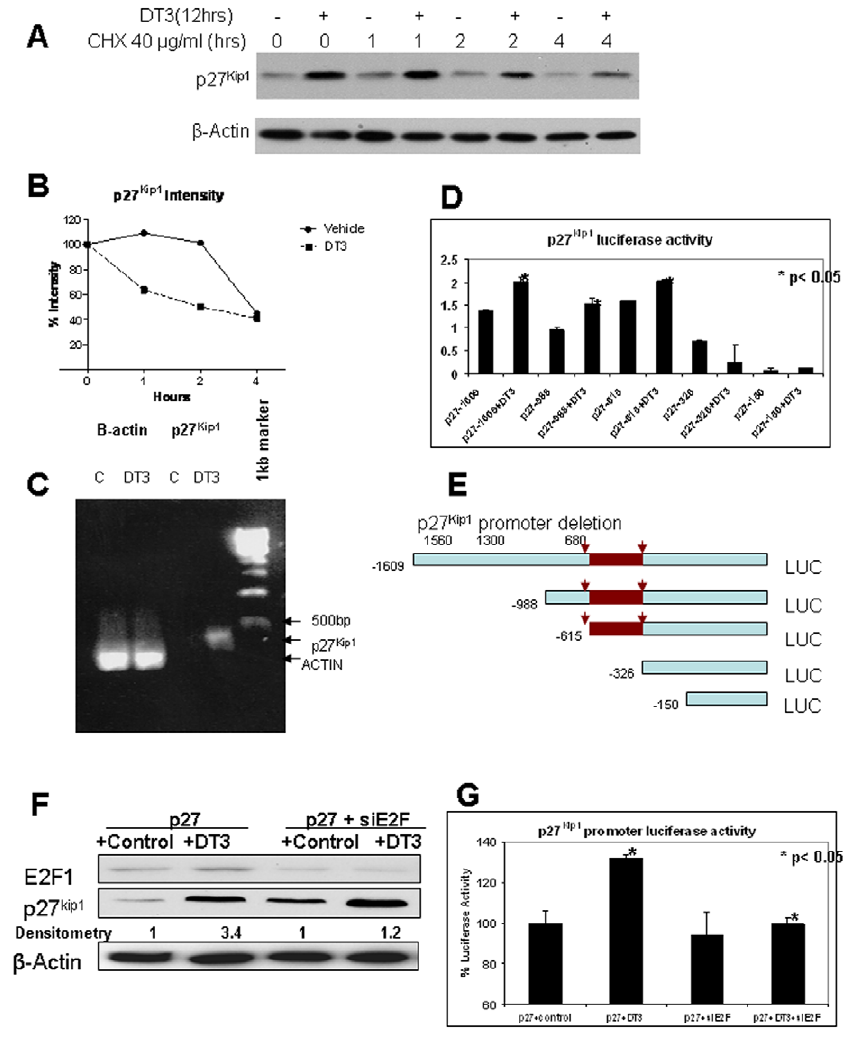
Figure 4. d -Tocotrienol (DT3) regulation of p27 Kip1 protein expression at the transcription level. A, MIAPaca-2 cells were treated with d - tocotrienol at a predetermined IC 50 and then with cyclohexamide to block protein synthesis. p27 Kip1 turnover rate was examined by Western blot. B, densitometry plot for panel A using b -actin for density control, showing similar rates of degradation by d -tocotrienol. C, RT-PCR confirms upregulation of p27 Kip1 at the mRNA level. MIAPaCa-2 cells were treated with d -tocotrienol for 24 hours, and p27 Kip1 mRNA expression level was determined by RT-PCR at different amplification cycles. Representative result at cycle 40 is shown. D, activation of p27 Kip1 promoter by d -tocotrienol. MIAPaCa-2 cells were transfected with 5 9 -deletion mutants of the mouse p27 Kip1 promoter luciferase reporter. After 24-hour transfection, cells were treated with d -tocotrienol (IC 50 ) or vehicle for an additional 24 hours, and luciferase activity was determined. Deletion analysis of the mouse p27 Kip1 promoter suggests that the region between 326 and 615 contains sequences necessary for significant response to d -tocotrienol in p27 Kip1 reporter assays. E, illustration of 5 9 deletion mutants of the mouse p27 Kip1 promoter luciferase reporter. Sequence search of this region revealed several putative E2F-1 binding sites (TTTGGCTA, GCGCGGAG, GCGCCGAG) as demonstrated in the shaded area of the deletion mutant constructs. F , immunoblot showing suppressed E2F-1 expression using siRNA E2F-1, G , attenuated d -tocotrienol mediated effects on the transfected full-length p27 Kip1 promoter activity using a luciferase reporter assay.